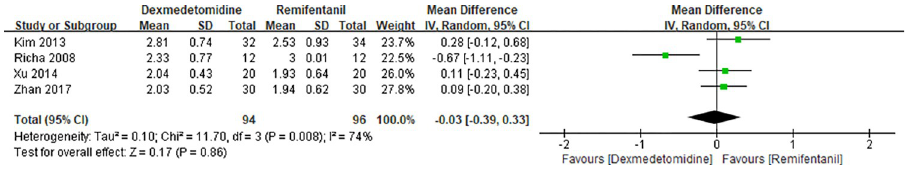
Fig 6. Forest plot of surgical field score. Dexmedetomidine group vs. remifentanil group.